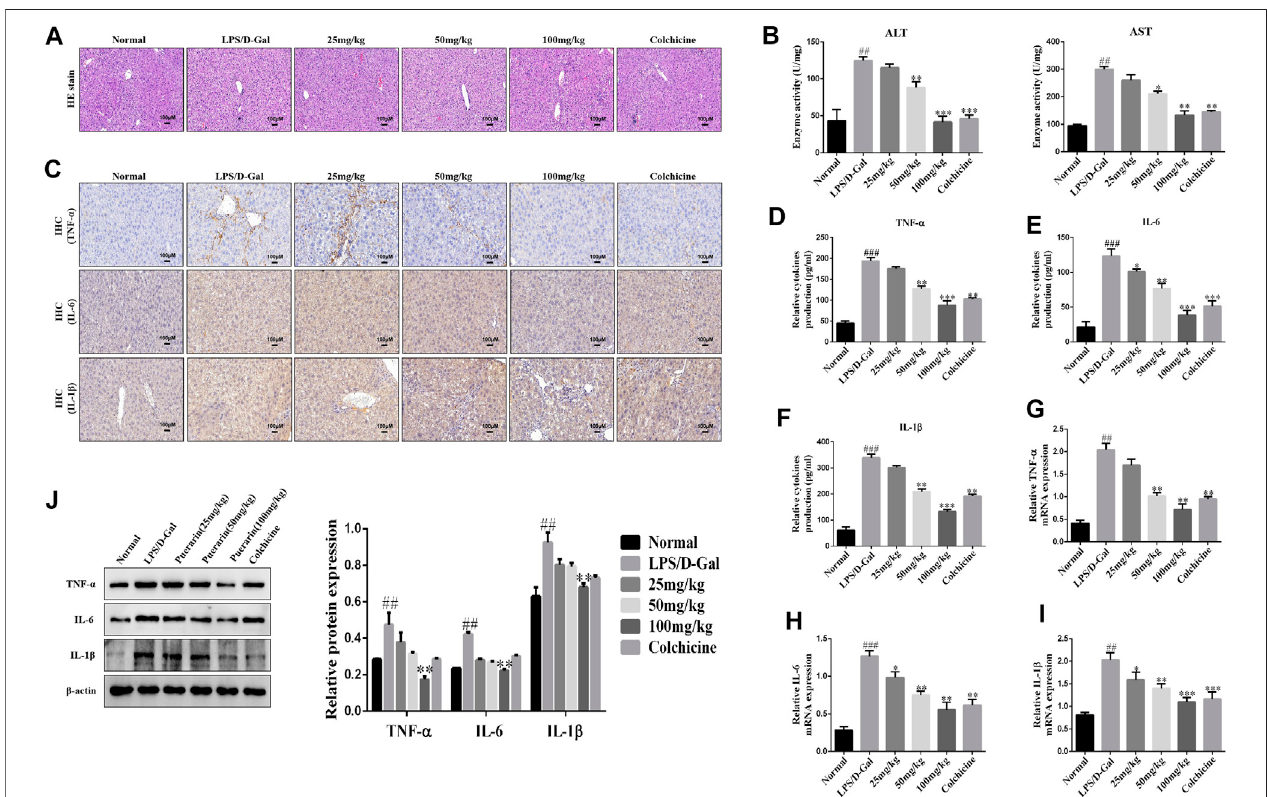
FIGURE 1 | Puerarin protected mice from acute liver injury (ALI) induced by LPS/D-Gal. (A) : Hematoxylin and eosin (H and E) staining was conducted, the specimens were examined under a microscope ( × 100), and in fl ammatory cell accumulation was counted. (B) : Serum activities of ALT and AST were measured ( n (cid:2) 6). (C) : Representative immunohistochemical stained images of in fl ammatory cytokines (D – F) : The in fl ammatory cytokines were measured using ELISA (G – I) : qRT-PCR analysis of TNF- α , IL-6, and IL-1 β mRNA levels in ALI liver tissues. (J) : Western blot analysis of TNF- α , IL-6, and IL-1 β protein levels in ALI liver tissues. The assays wereperformedatleastthreetimes,withsimilarresults.Dataareshownasthemeans ± SD( n (cid:2) 3)ofonerepresentativeexperiment; ###p and ##p < 0.01versusnormal groups; ***p < 0.001 and **p < 0.01 and *p < 0.05 versus the LPS/D-Gal group.